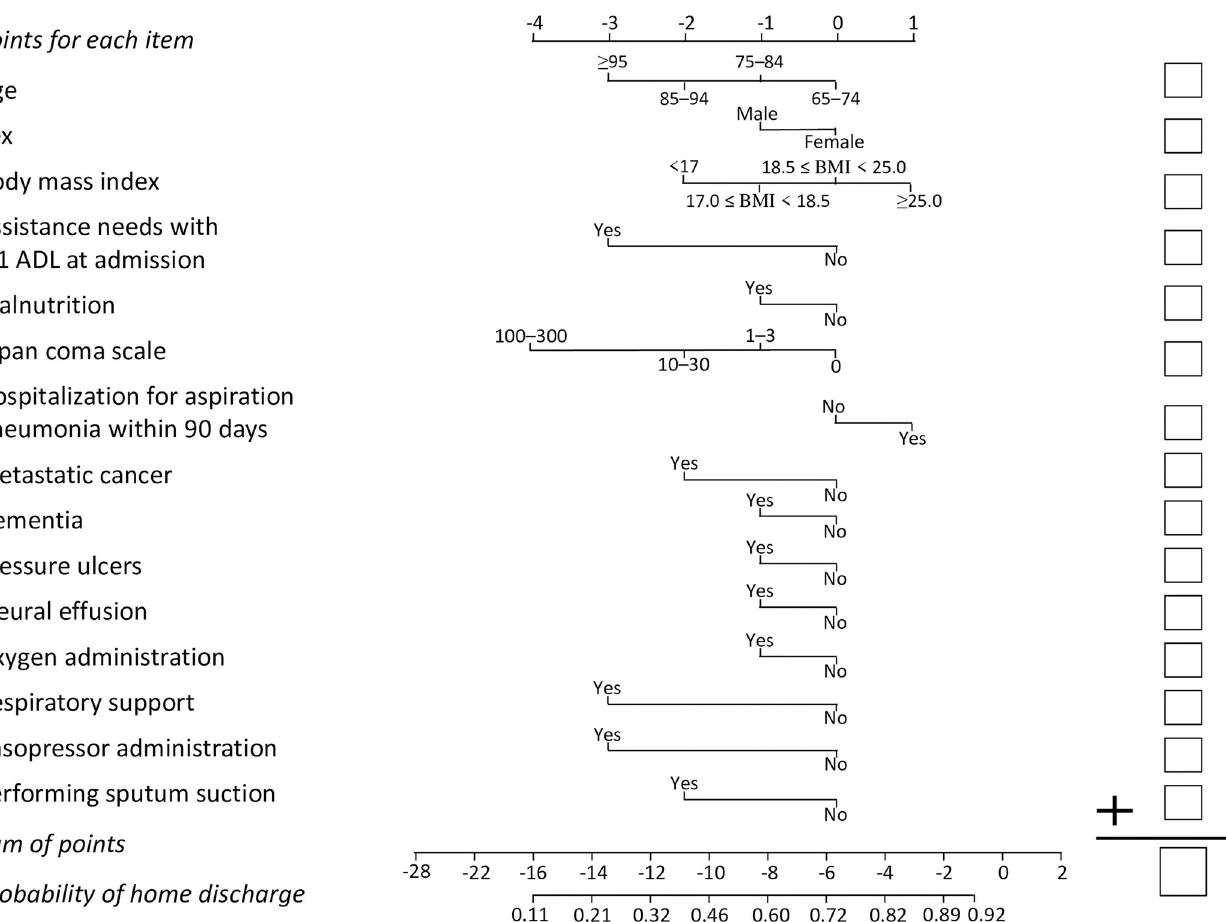
Fig 5. Nomogram for estimating the probability of home discharge for cases admitted from home. Draw a vertical line upward from the corresponding value of each predictor to the points bar to obtain the points for each item. Based on the sum of the points for each item, draw a vertical line downward from the corresponding sum of the points to calculate the probability of home discharge. ADL were defined as the 10 components of the Barthel index (feeding, bathing, grooming, dressing, bowel control, bladder control, toilet use, transfers from bed to chair, mobility on level surfaces, and stairs). Malnutrition was defined as a serum albumin level of 3.0 g/dL or less, parenteral nutrition, or tube feeding at admission. Respiratory support included high-flow nasal cannula, noninvasive ventilation, and invasive mechanical